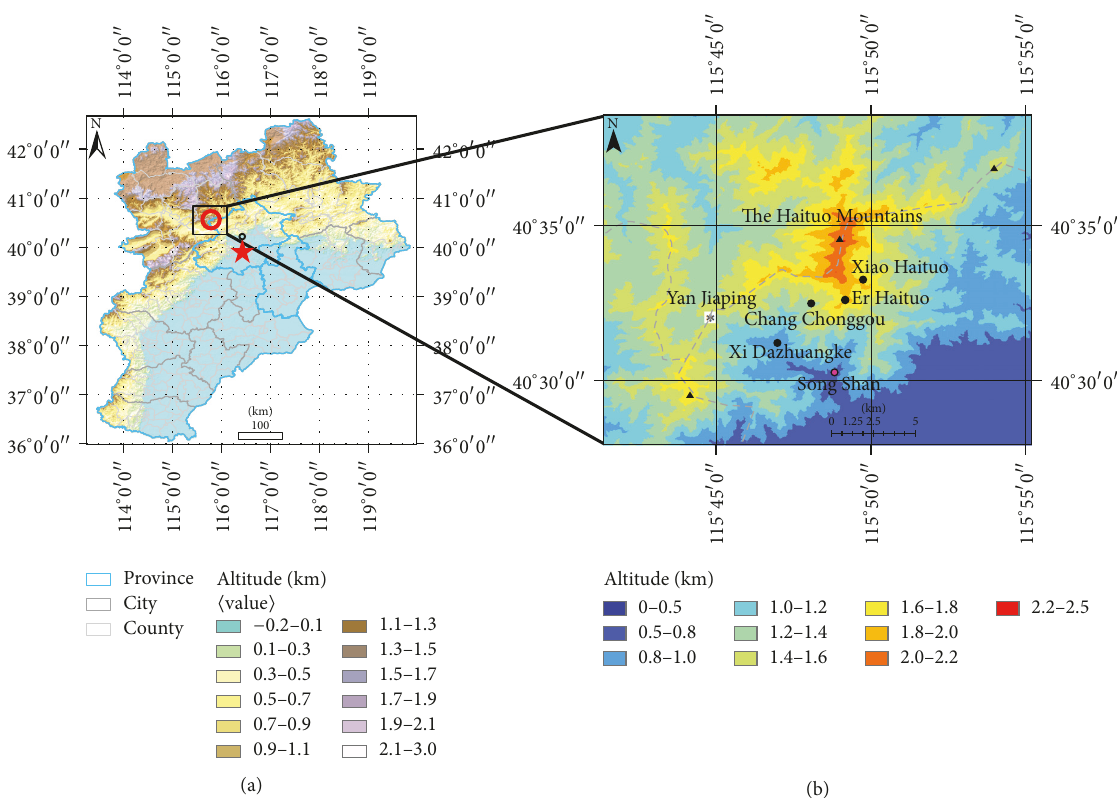
Figure 1: (a) Location of the Haituo Mountains (red circle) experimental area (black box) and airport (black circle) in the Beijing and Hebei province; red star is downtown Beijing. (b) Location and orography (m) of the Yan Jiaping integrated observation station (snowflake) and meteorological automatic stations (black and red points) and black triangle is the top of the Haituo